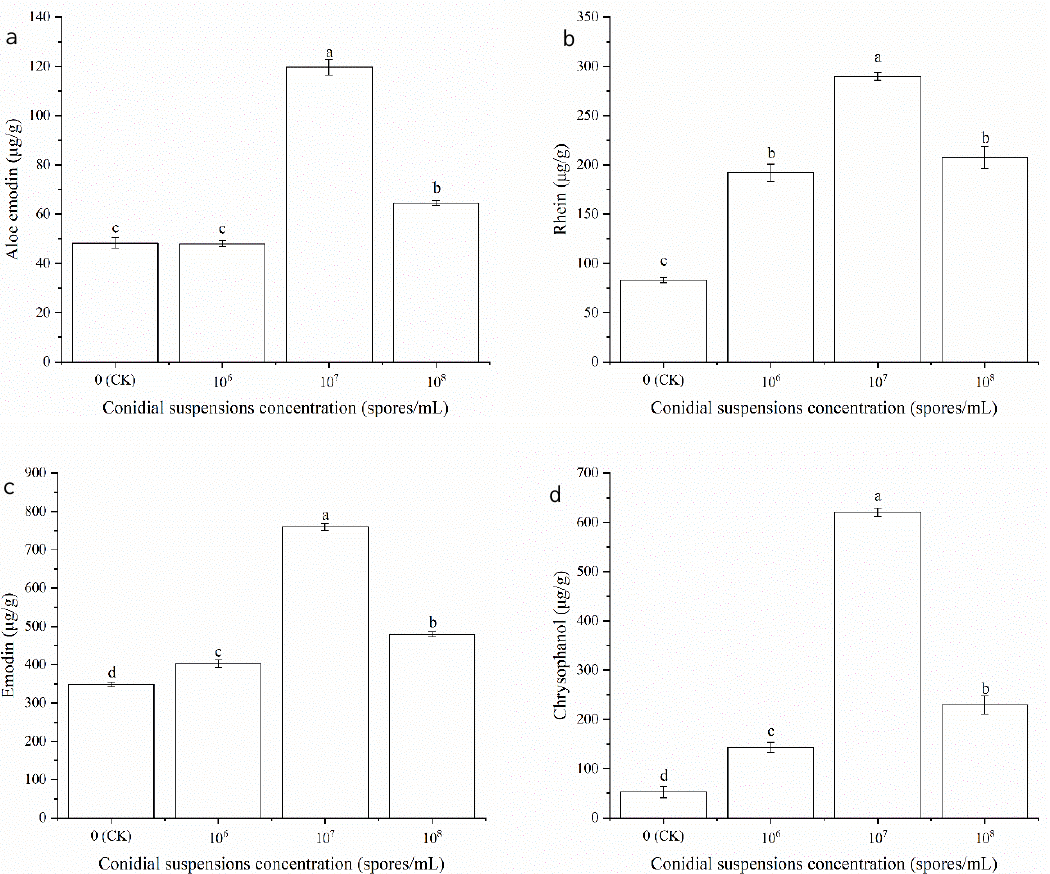
Figure 4. Effects of different concentration conidial suspensions HT-1 strain on metabolites accu- mulation in R. palmatum . ( a ) Aloe emodin; ( b ) Rhein; ( c ) Emodin; ( d ) Chrysophanol. Values are mean ± SD ( n = 5 replicates). Different letters above the bars indicate the differences are significant at p < 0.05.